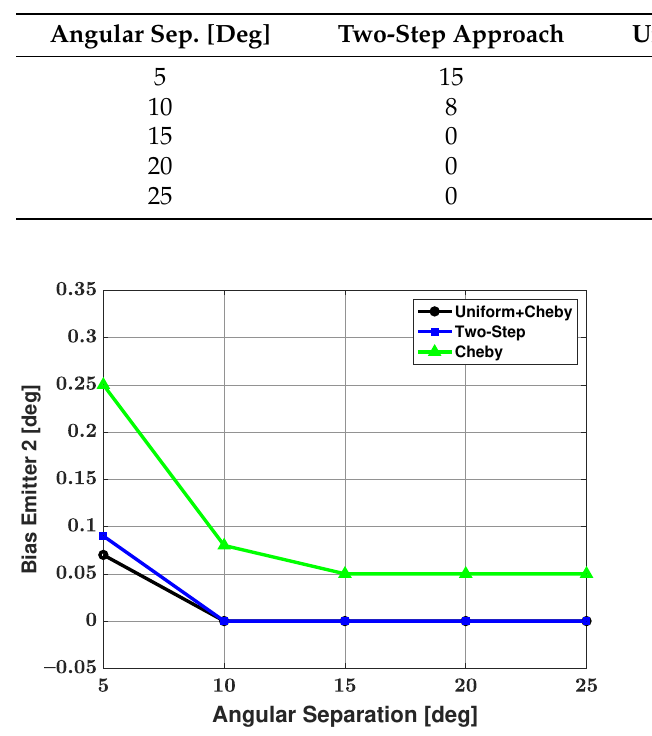
Figure 6. Bias in the estimated direction of the second, weaker emitter versus angular separation between the two emitters: the three proposed methods are used for estimation, SNR of emitter #1 = 25 dB and emitter #2 = 0 dB, respectively; 100 snapshots, and 500